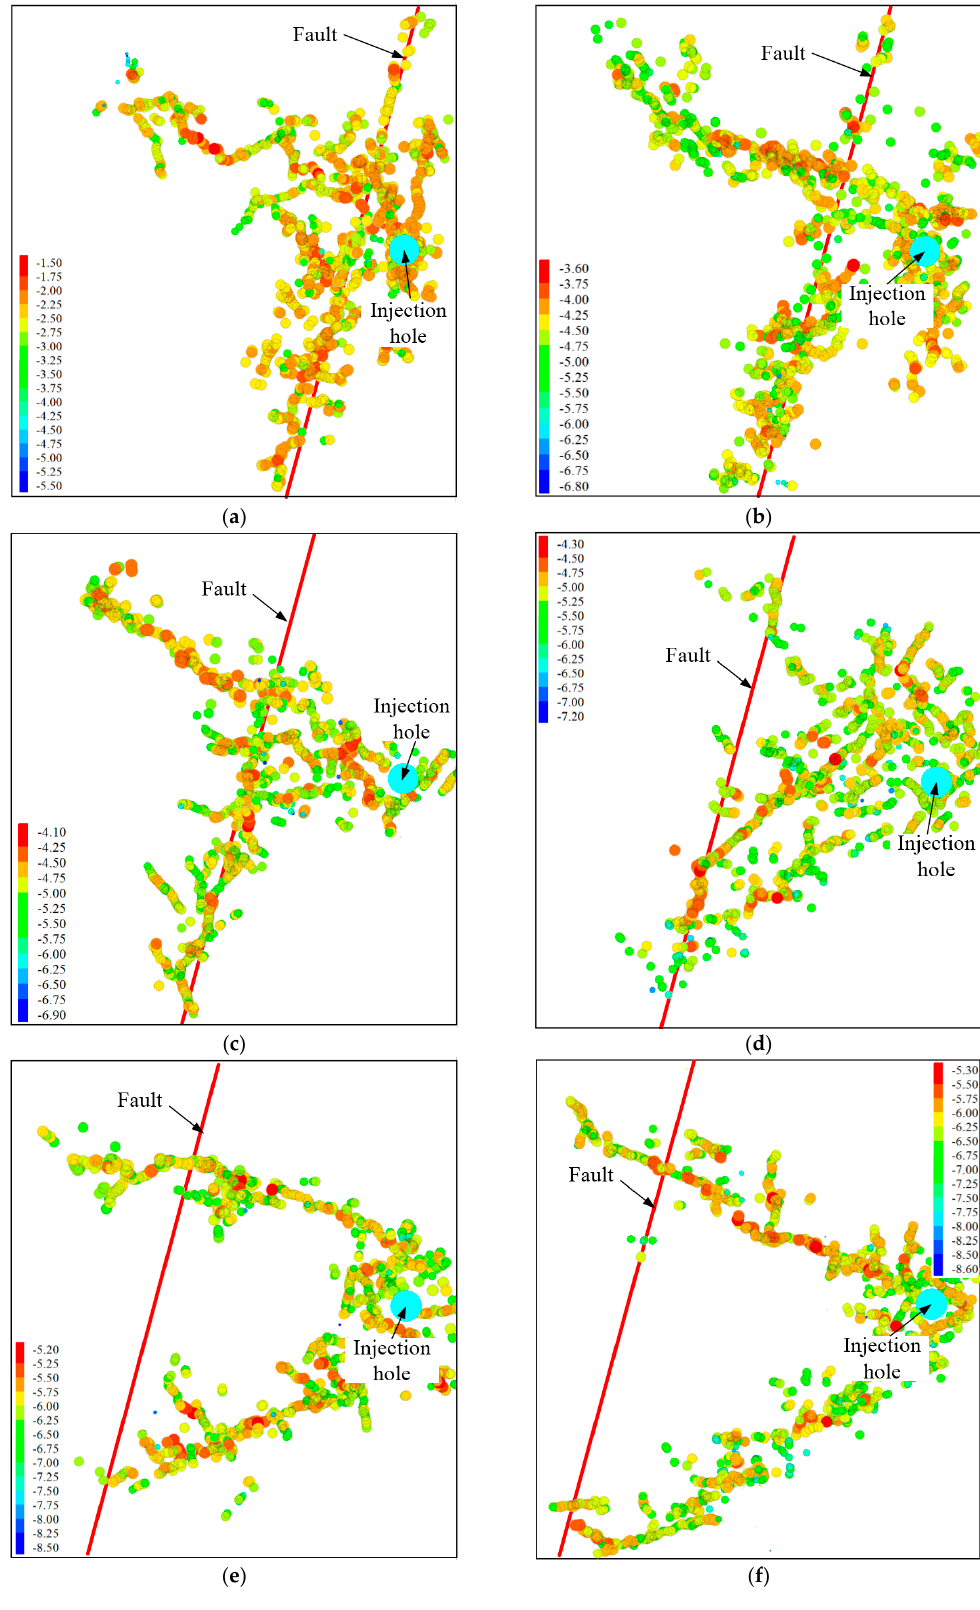
Figure 14. Simulated injection-induced seismic events with variation in the distance between the injection hole and the fault: ( a ) L if = 10 m; ( b ) L if = 20 m; ( c ) L if = 30 m; ( d ) L if = 40 m; ( e ) L if = 50 m; and ( f ) L if = 60 m.